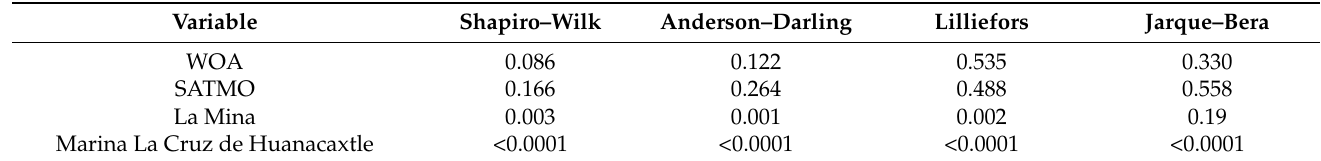
Table 7. Test of normality for the SATMO, WOA and in situ databases.